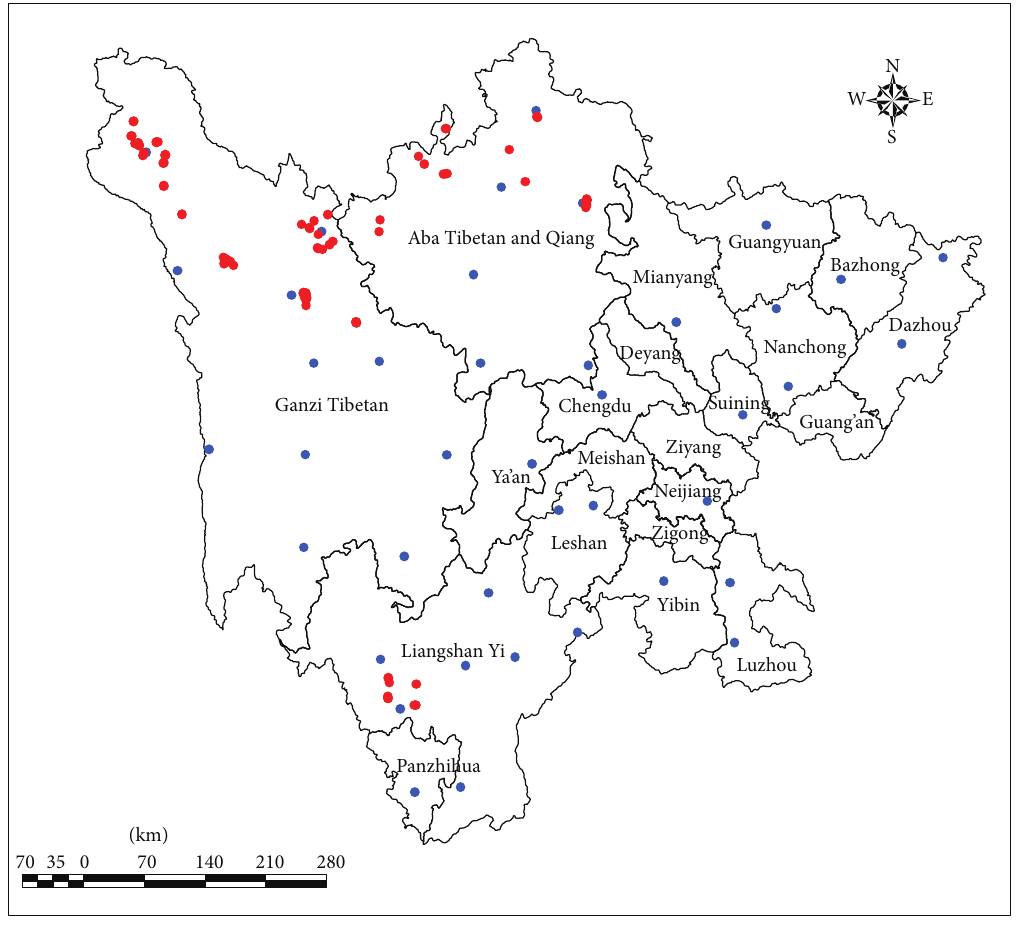
Figure 2: Distribution of in situ measurement locations and meteorological stations in Sichuan